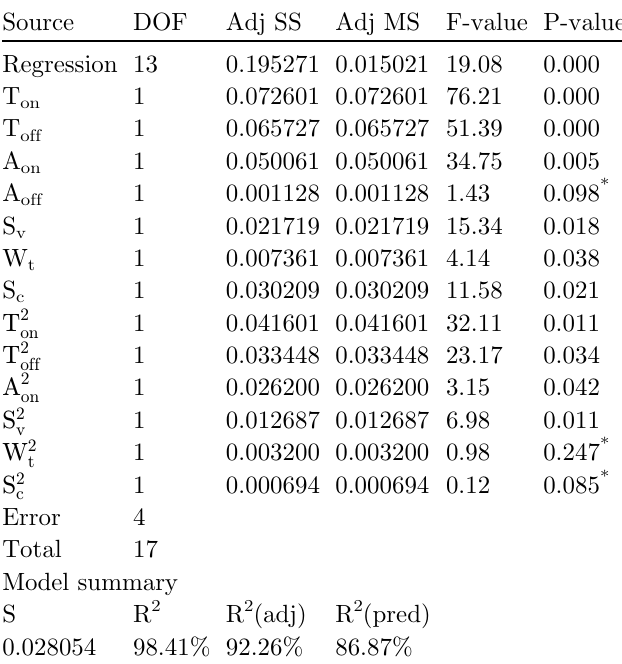
Table 5. ANOVA for surface